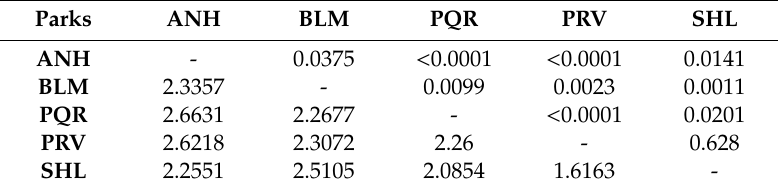
Table 3. Mahalanobisdistances(belowdiagonal)and p values(abovediagonal)for Ae. albopictus populations. Parks ANH BLM PQR PRV SHL ANH - 0.0375 <